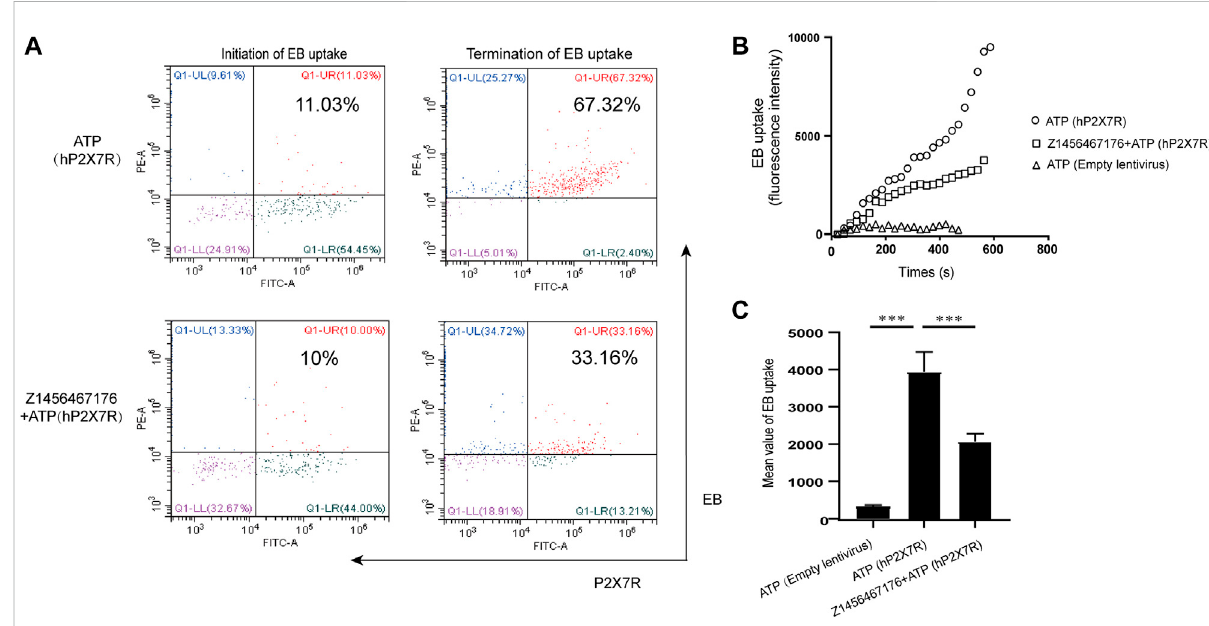
FIGURE. 1 Z1456467176 inhibits ATP-induced P2X7R pore formation. (A) Representative fl ow diagram of EB uptake by HEK-293T cells overexpressing hP2X7RinresponsetoATP.TheredQ1-URregionre fl ectsdouble-positivestainingforEBandhP2X7R.FACSanalysisoftheintracellular fl uorescence intensity (B) and mean value analysis of quanti fi ed intracellular fl uorescence intensity (C) . Data are presented as the means ± S.E.M.s. Statistics were analyzed using Dunnett ’ s t -test. *** p < 0.001.